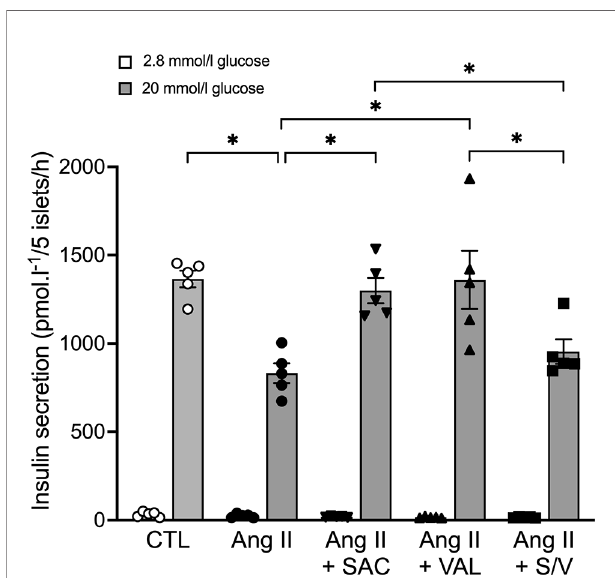
FIGURE 7 | Sacubitrilat and valsartan alone but not combined, increase glucose-stimulated insulin secretion in angiotensin II-treated islets. Insulin secretion in response to 2.8 mmol/l (white bars) and 20 mmol/l (grey bars) glucose in isolated islets from lean C57BL6/J mice following incubation with vehicle (CTL, open circles), 100 nmol/l angiotensin II alone (Ang II, black circles), 100 nmol/l angiotensin II + 1 m mol/l sacubitrilat (SAC, black inverted triangles), 1 m mol/l valsartan (VAL, black triangles), or 1 m mol/l sacubitrilat and 1 m mol/l valsartan (S/V, black squares). Data are mean ± S.E.M of 5 independent experiments.